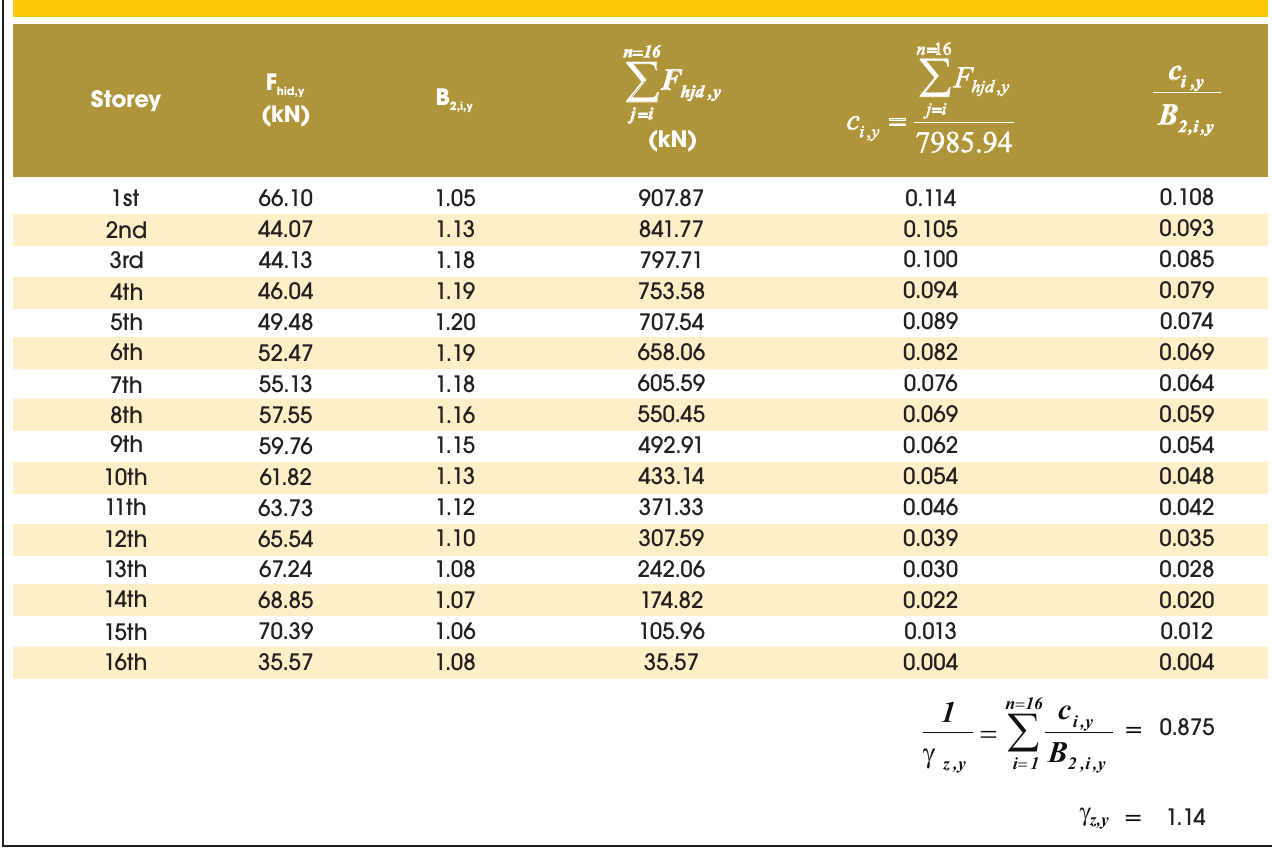
Table 5 – Calculation of the  coefficient, from the values of B , in direction Y, for building I